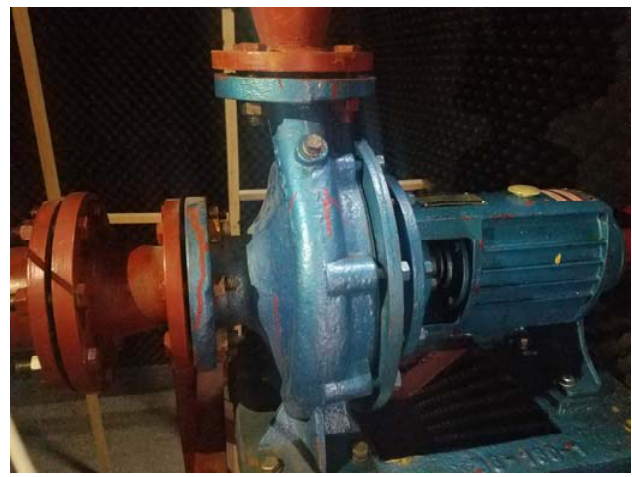
Figure 1. Prototype figure of the test pump. Table 1. Geometric and performance parameters of the test pump.